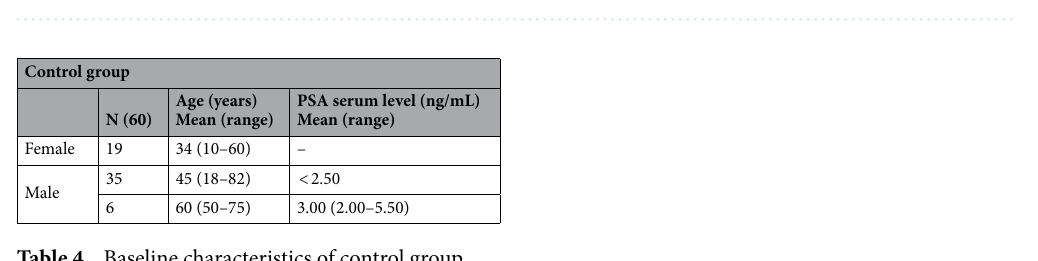
Table 3. Baseline characteristics of prostate cancer